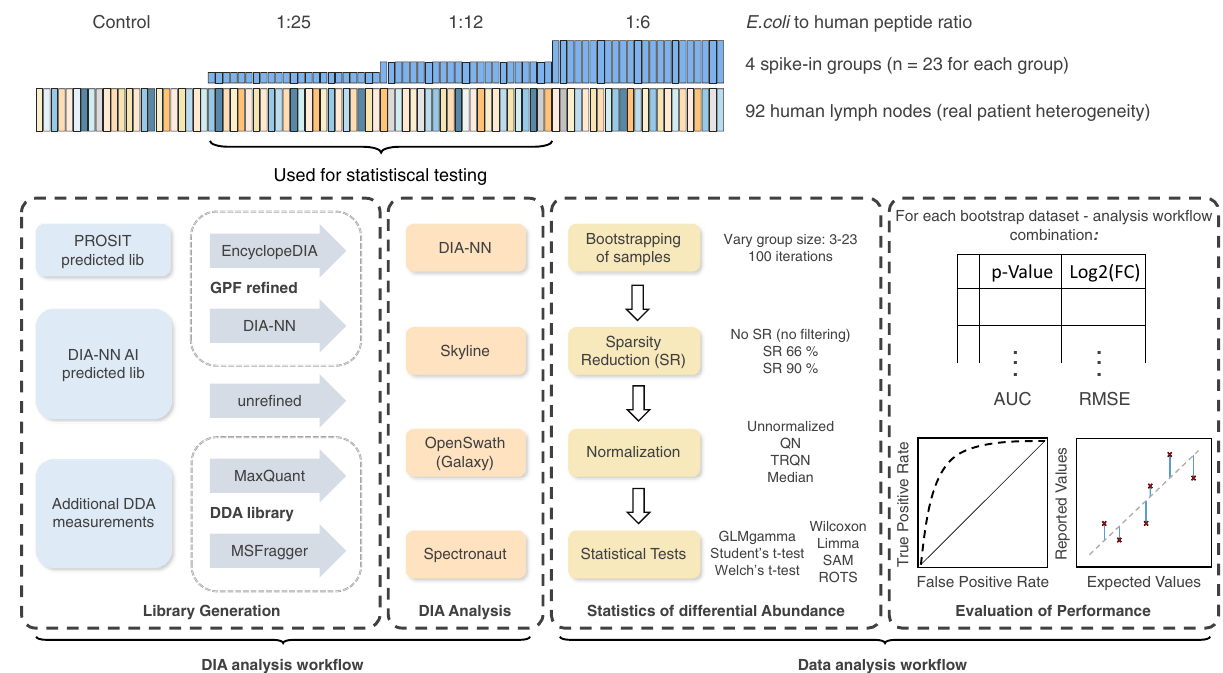
Fig. 1 Benchmarking work fl ow. A data-independent acquisition (DIA) benchmark dataset was created by adding E. coli peptides in known ratios to peptide preparations of lymph nodes of 92 individuals. We analyzed the raw data with different spectral libraries and DIA software suites. From samples to which E. coli peptides were added in the two E. coli : human peptide ratios 1:25 and 1:12, bootstrap datasets with group sizes of 3 to 23 were generated. For each of those 21 different group sizes, 100 bootstrap datasets were generated. On each bootstrap dataset different data analysis work fl ows, composed of different sparsity reductions, normalization options, and different statistical tests for detecting differentially abundant proteins, were applied. The results were returned in a table containing p -values and log2 fold-changes (log2FCs) for each protein. As the ground truth about the changed proteins ( E. coli ) is known, the prediction performance of each work fl ow can be assessed. This can be done based on the p -values from the statistical tests by calculating the receiver operating characteristic (ROC) curve, based on which the area under curve (AUC) is calculated. To quantify the accuracy of quanti fi cation the root-mean- square error (RMSE) is calculated based on the detected